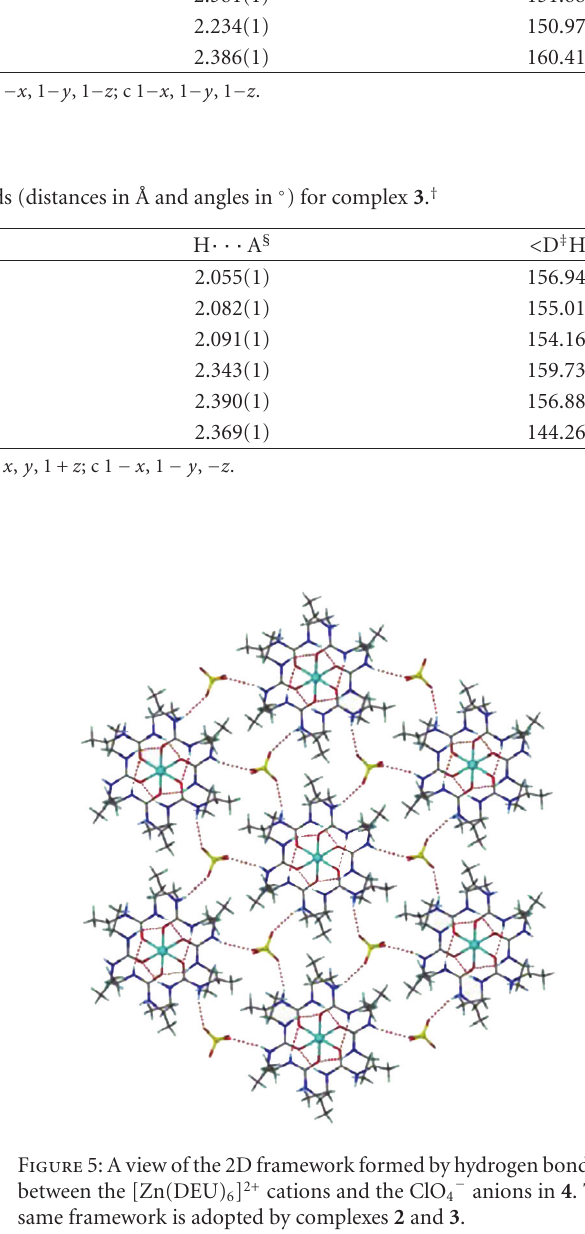
Table 8: Dimensions of the unique hydrogen bonds (distances in ˚A and angles in ◦ ) for complex 3 . †